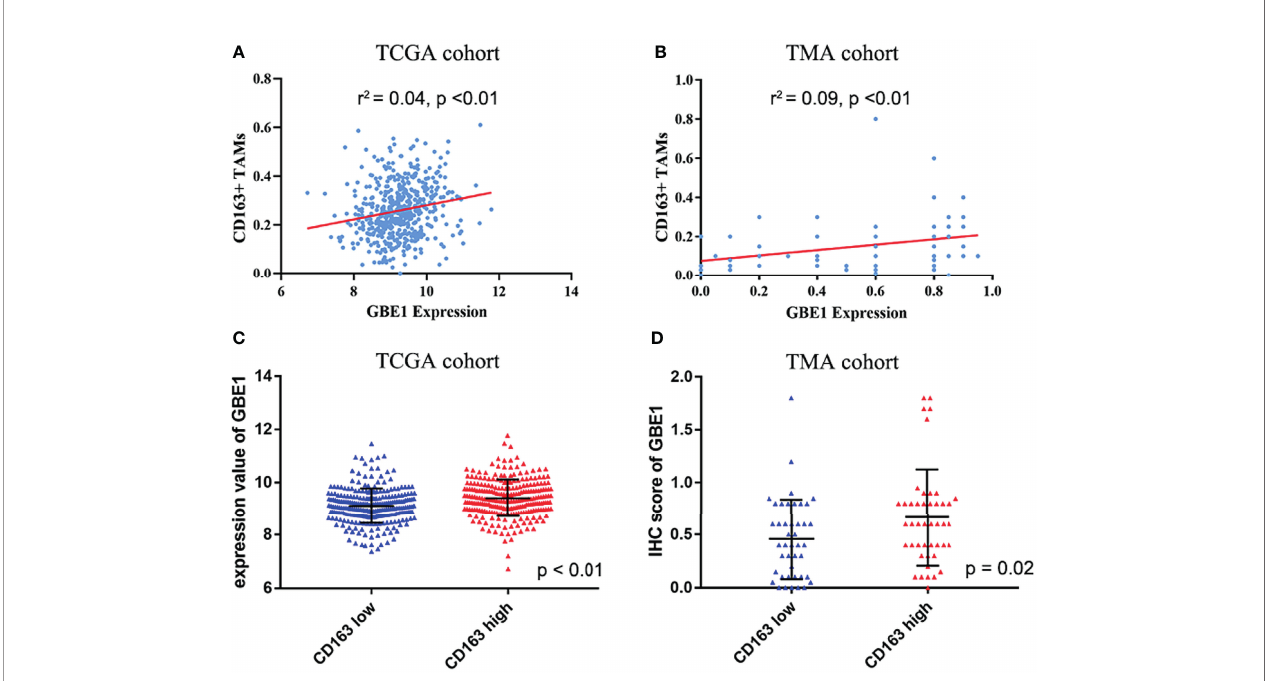
FIGURE 7 | The relationship between GBE1 expression and M2 macrophage in fi ltrations in LUAD. (A, B) The correlations between GBE1 expression and CD163 + tumor-associated macrophage in fi ltration in TCGA and TMA cohorts ( r 2 = 0.04, p < 0.01; r 2 = 0.09, p < 0.01). (C) The correlation between GBE1 expression and CD163 expression in TCGA cohort ( p < 0.01). (D) The correlation between GBE1 expression and CD163 expression in the TMA cohort ( p =